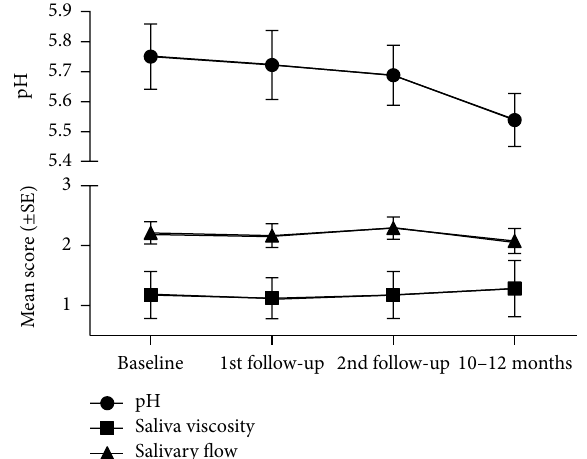
Figure1:Changesinsalivaryviscosity,visualflow,andpHmeasures before and after insertion of new dentures at follow-up appoint- ments. Values are represented as mean and standard error (SE).